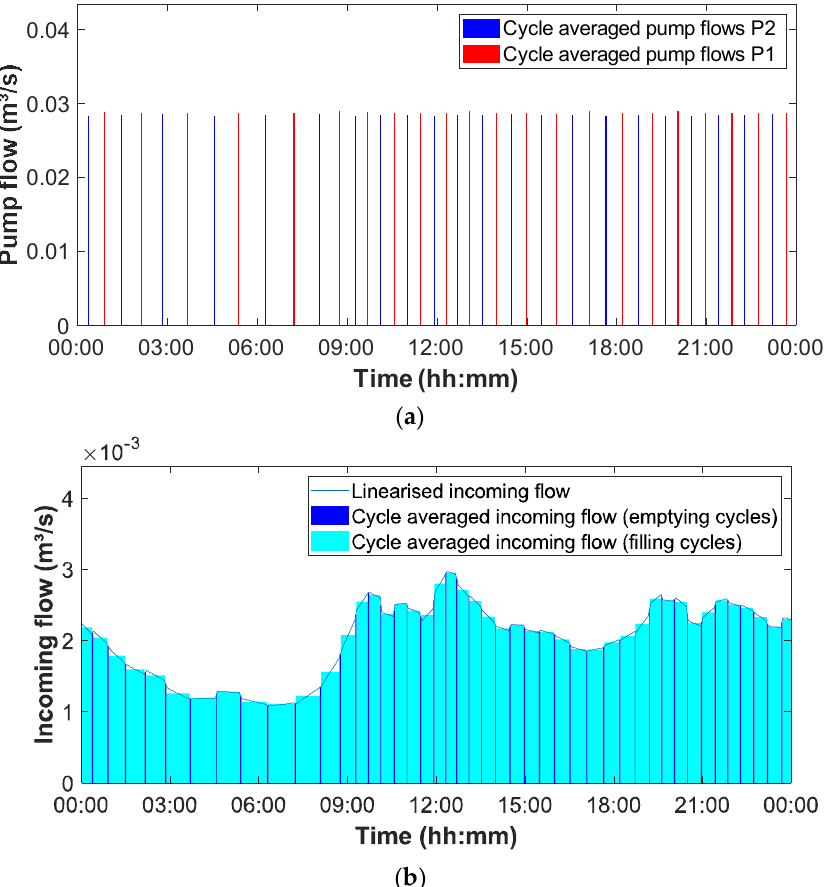
Figure 6. Example of individual cycles’ flows: ( a ) pumped flows per cycle per pump (top); ( b ) aver- age incoming flows for filling and emptying cycles and linearised flows for all cycles (bottom) (PS Zuidstraat).